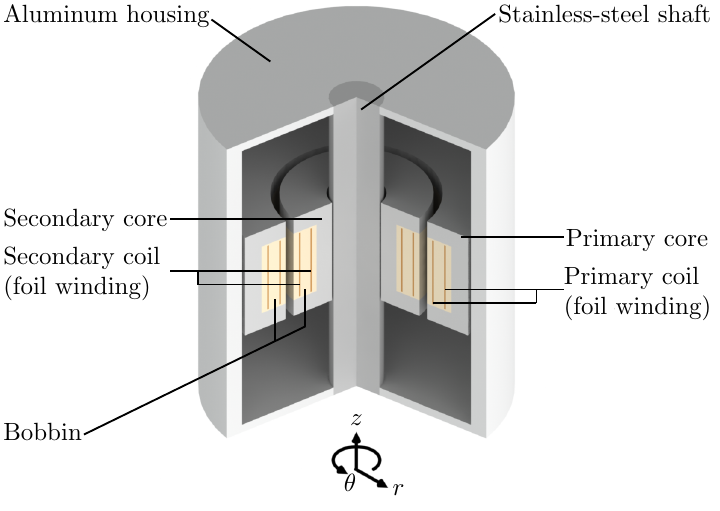
Figure 1. Overview of the benchmark system in 3D